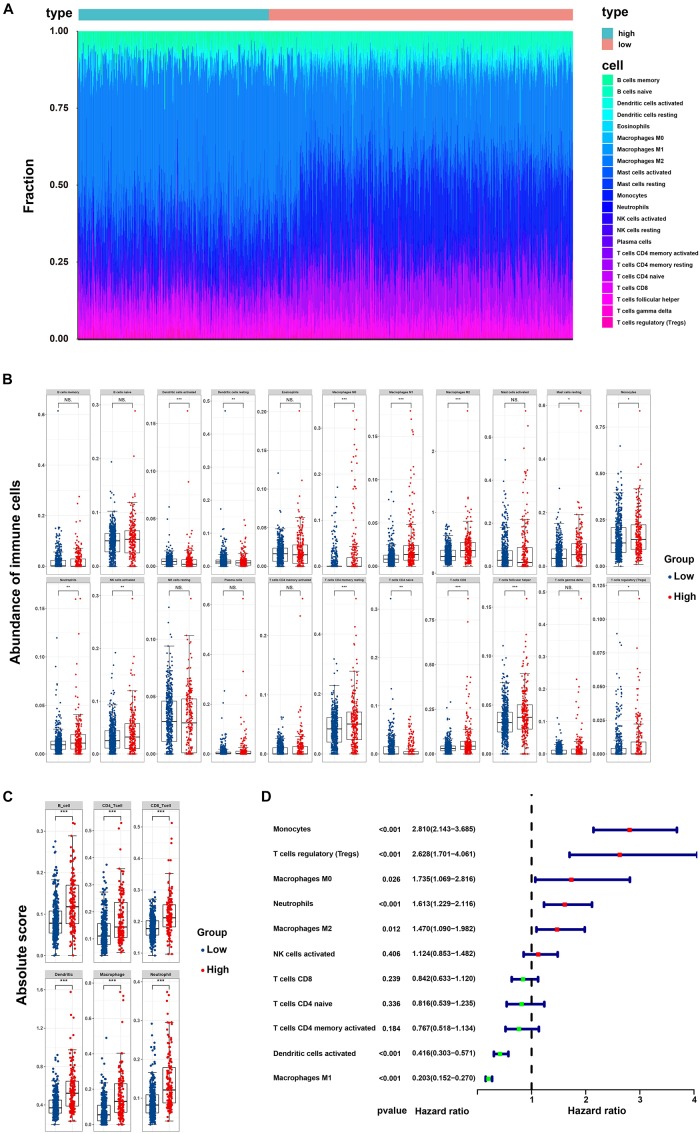
Correlation of the risk score with infiltrative immune cells. (A) Barplot showing the percentages of 22 infiltrative immune cells calculated by CIBERSORTx between high-and low-risk groups in primary LGG from TCGA and CGGA cohorts (high-risk, 232 samples; low-risk, 551 samples); (B) Boxplot showing the differential abundance of 22 infiltrative immune cells calculated by CIBERSORTx between high-and low-risk group in primary LGG; (C) Boxplot showing the differential abundance of six infiltrative immune cells by TIMER database between high-and low-risk group in primary LGG; (D) Forest plot of hazard ratios demonstrating the prognostic values of 22 immune cells calculated by CIBERSORTx in primary LGG. The dash line was used to mark the location of HR = 1. The red box represents the adverse prognostic factor, and the blue box represents the favorable prognostic factor.